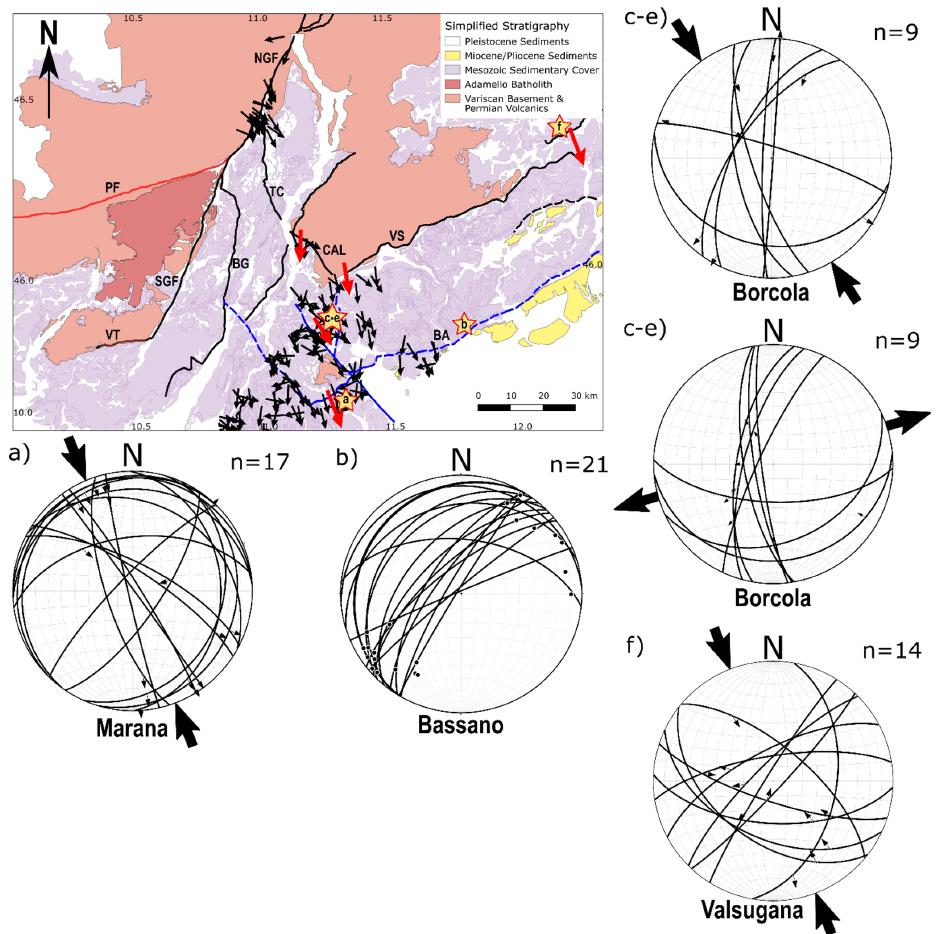
Figure 4. Structural map of the eastern Southern Alps showing the distribution of fault slip data from this study (in red; locations a–e indicated by stars on the map) and from the literature (in black). The geological map is a compilation of own field data and published geological maps (Bartolomei et al., 1969; Bosellini et al., 1969; Castellarin et al., 1968, 2005; Braga et al., 1971; Dal Piaz et al., 2007; Avanzini et al., 2010). See Fig. 1 for fault abbreviations. The field data include fold axes plotted on their fold axial planes for the Bassano Fault (b) and fault-slip analyses with local paleostrain directions for the Marana (a), Valsugana (f), and Borcola (c–e) faults. Two distinct stereoplots are shown for Borcola as two generations of striations are observed here (see discussion in Sect. 3). Regional (Castellarin and Cantelli, 2000; Zampieri et al., 2003) and local (Prosser, 1998, 2000; Viola et al., 2001) paleostrain analyses from the literature are indicated in black. The data indicate a dominant NNW–SSE shortening